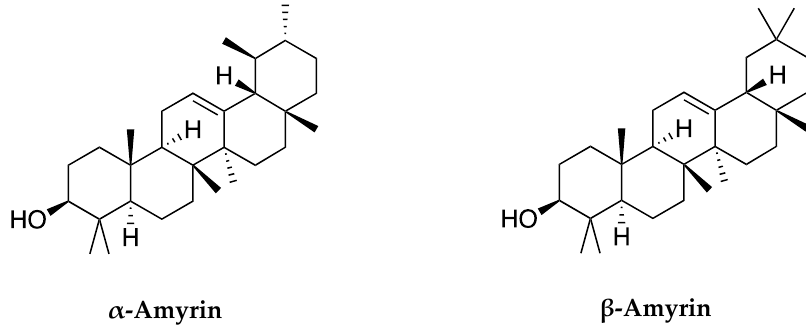
Figure 5. Chemical structures of α -amyrin and β -amyrin identified in C. hindsii Figure 5 . Chemical structures of α -amyrin and β -amyrin identified in C. hindsii.